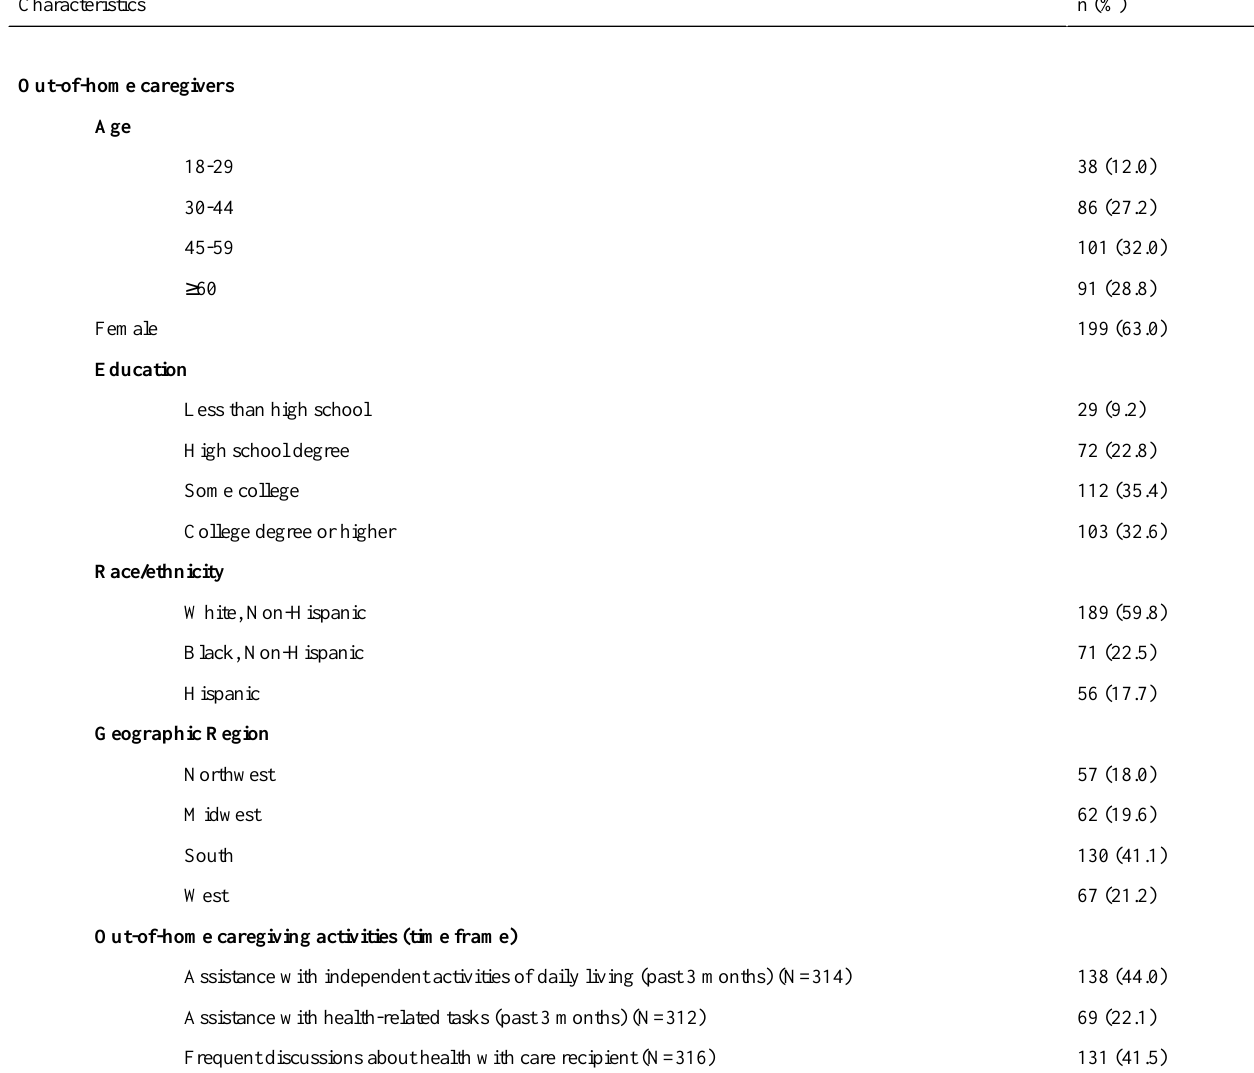
Table 1. Description of study population (N=316). a